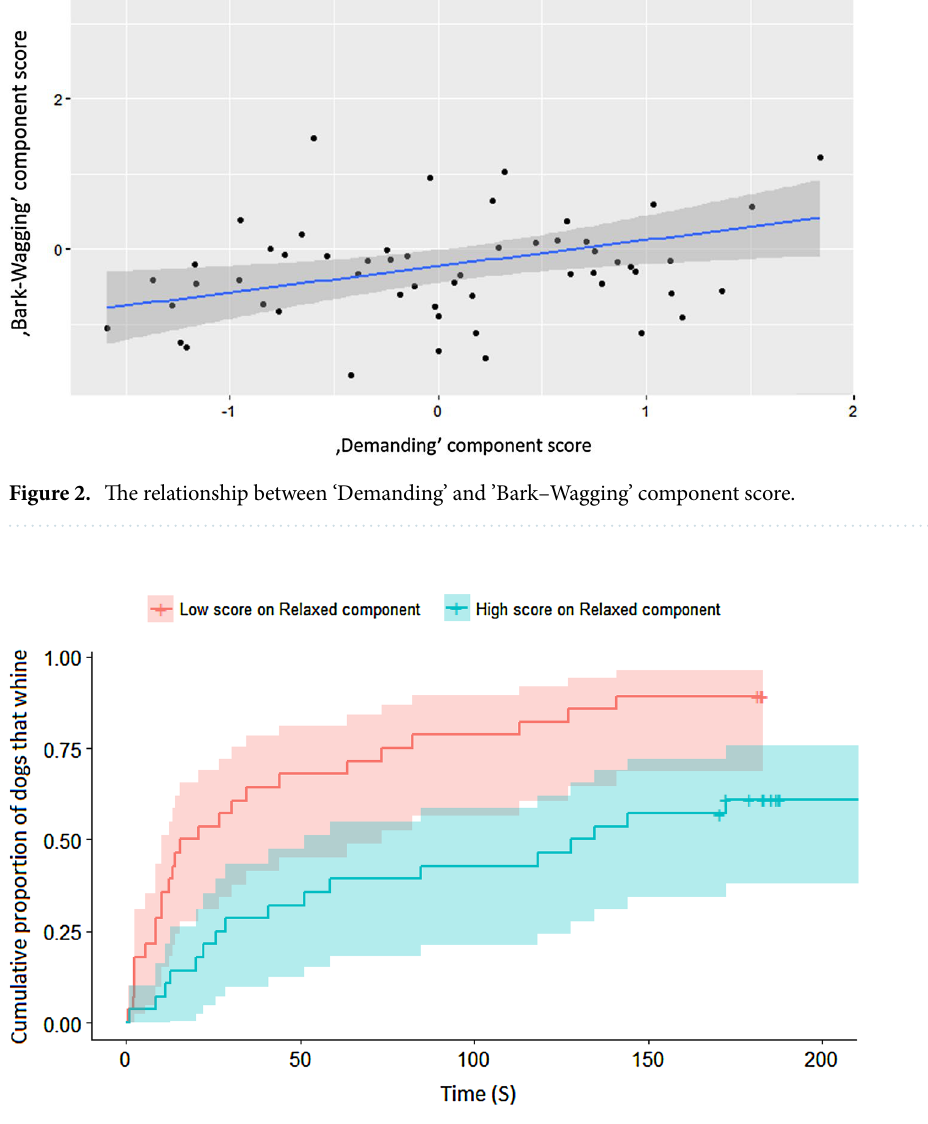
Figure 3. Differences based on the ’Relaxed’ component in the probability of whining during the separation